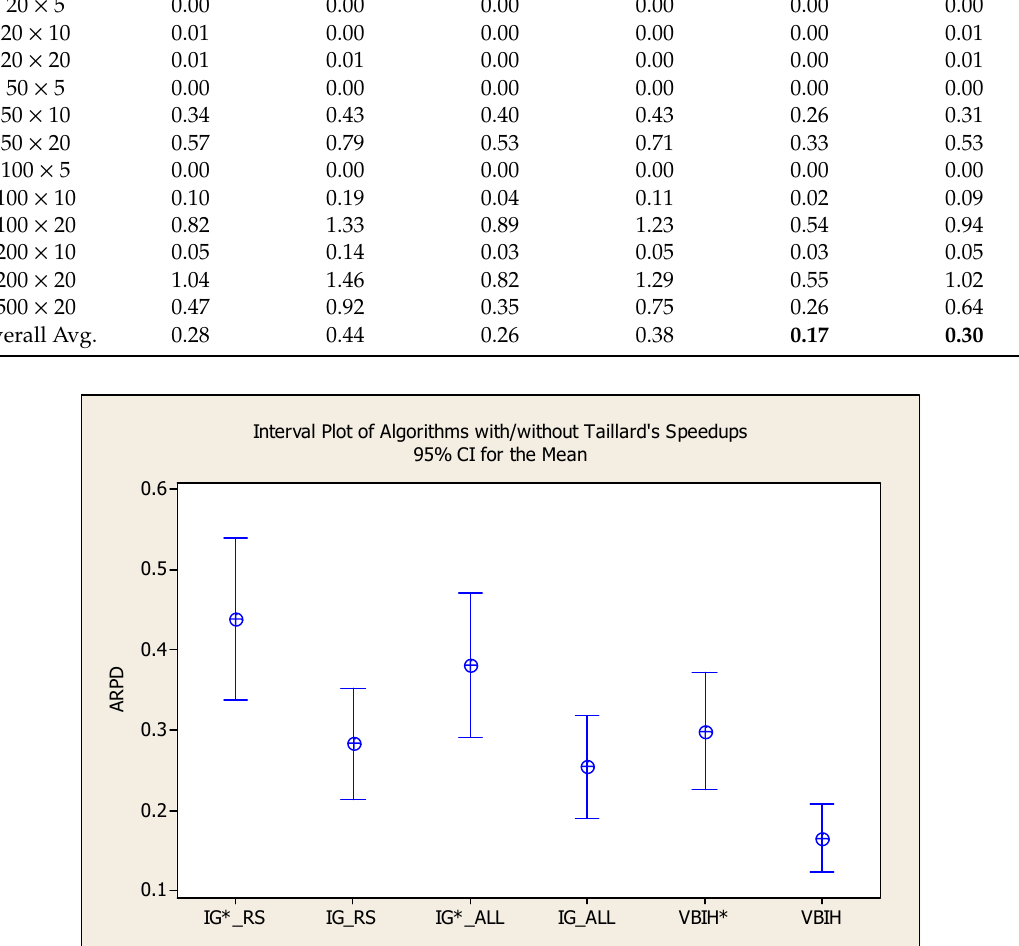
Figure 10. Interval plot at the 95% confidence level for Taillard’s